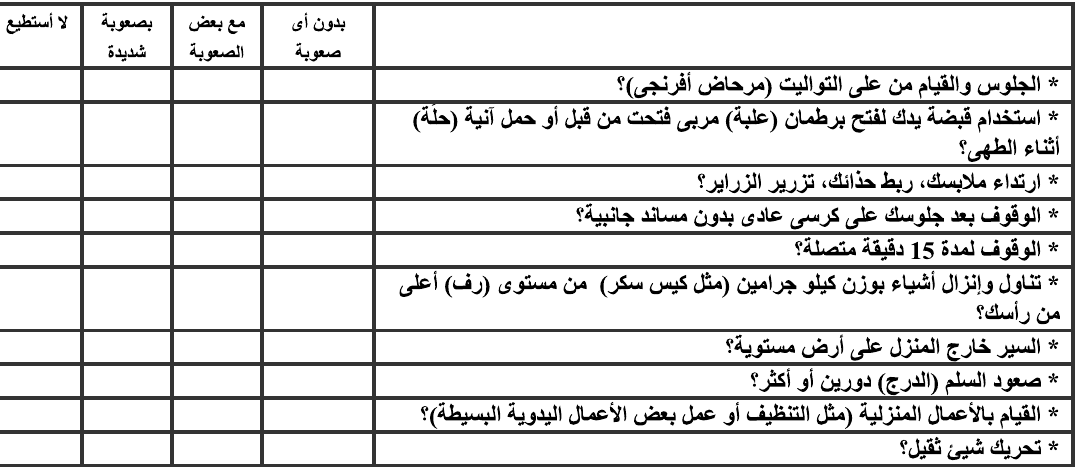
Table 4 Functional disability